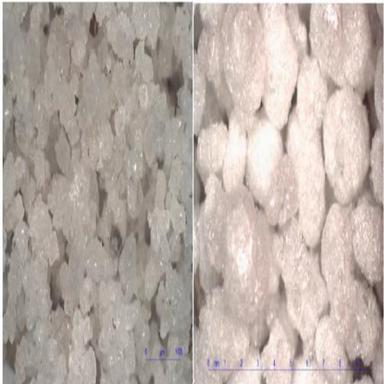
Expanded perlite particles.